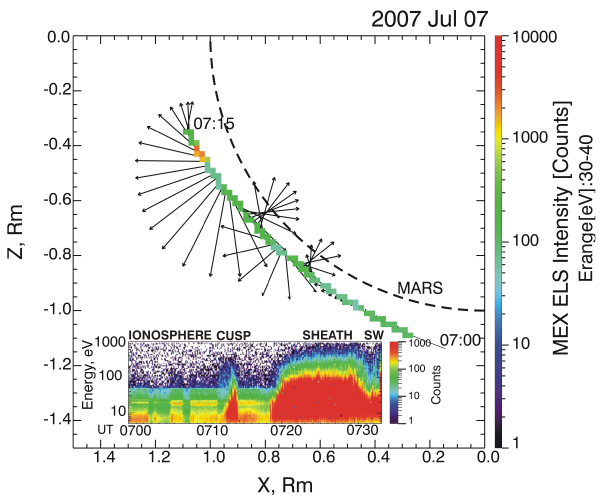
field strength at the altitude of the boundary is about 15–